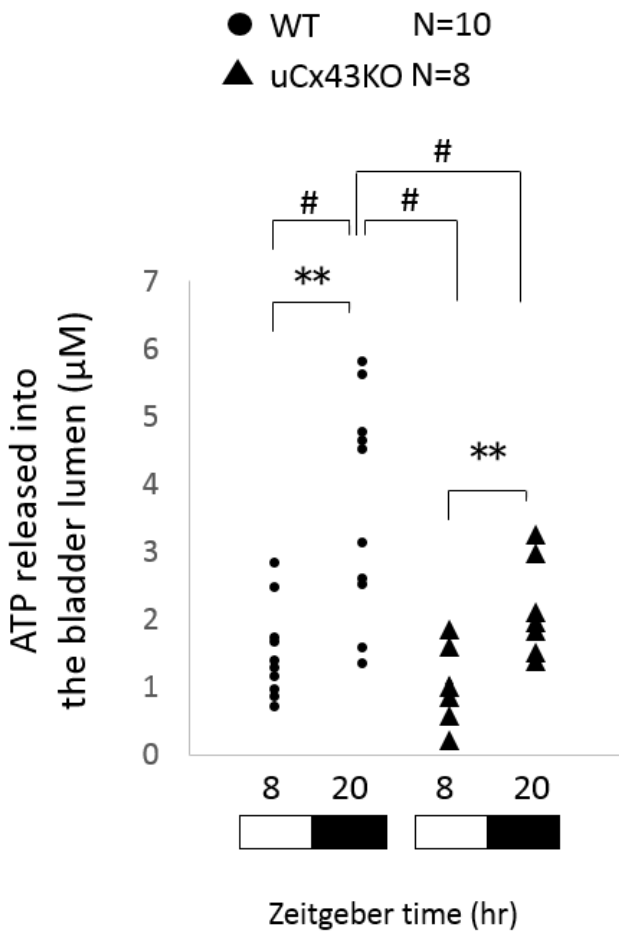
Figure 2. Comparison of the temporal changes in distension-induced luminal ATP release in WT and uCx43KO mice. Luminal ATP released amounts in response to bladder distension quantified from WT ( n = 10) and uCx43KO ( n = 8) mice during sleep phase (light phase; ZT8) and active phase (dark phase; ZT20). Note higher ATP release amounts from WT mice during the awake phase when compared to the sleep phase. This temporal difference remains in uCx43KO but is significantly attenuated when compared to WT mice. ZT, zeitgeber time: light on at ZT0 and off at ZT12. ** p < 0.01 Student’s t -test. # p < 0.01 versus the WT ZT20 group, one-way ANOVA followed Dunnett’s post hoc test.